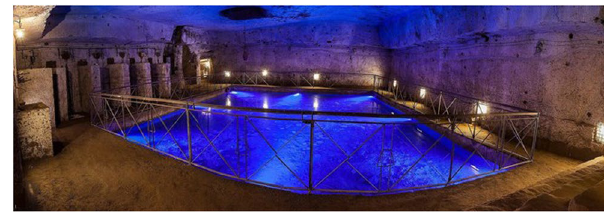
Figure 4. The water cistern, as seen from the detector location.